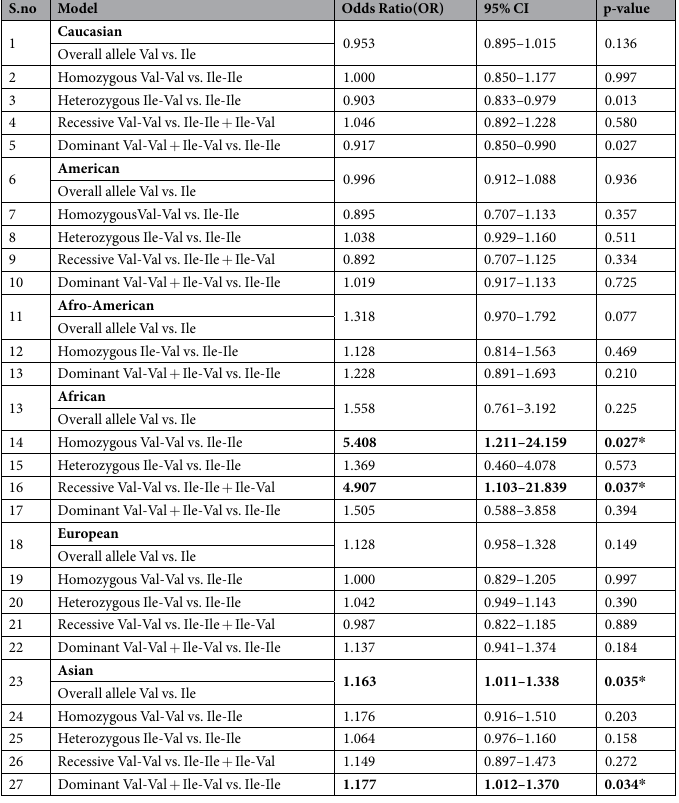
Table 3. Subgroup analysis of Her2 Ile 655 Val polymorphism and its association with breast cancer